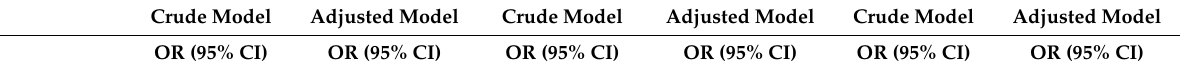
Table 4. Binominal logistic regression of depressive symptoms in relation to different activity contexts.